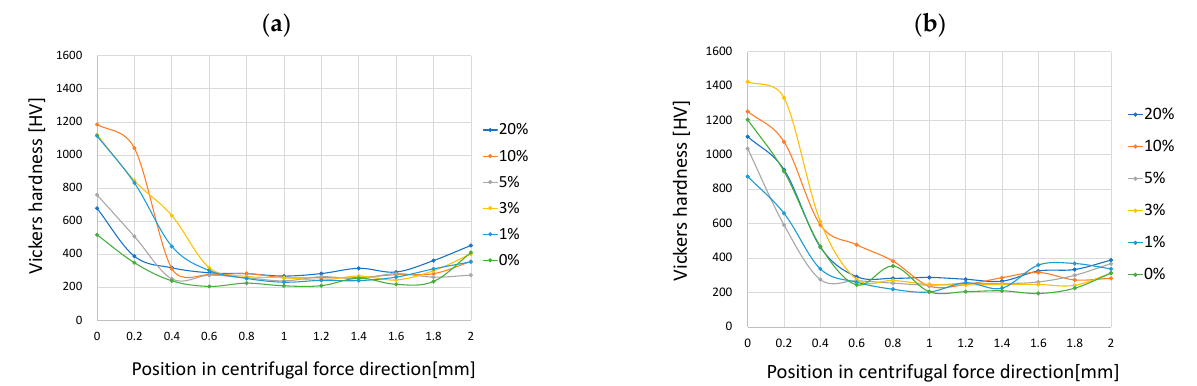
Figure 12. Vickers hardness in cross sections in centrifugal force directions in the samples with rotation speeds of 250 rpm ( a ) and 1000 rpm ( b ) for a variety of amounts of PCA.